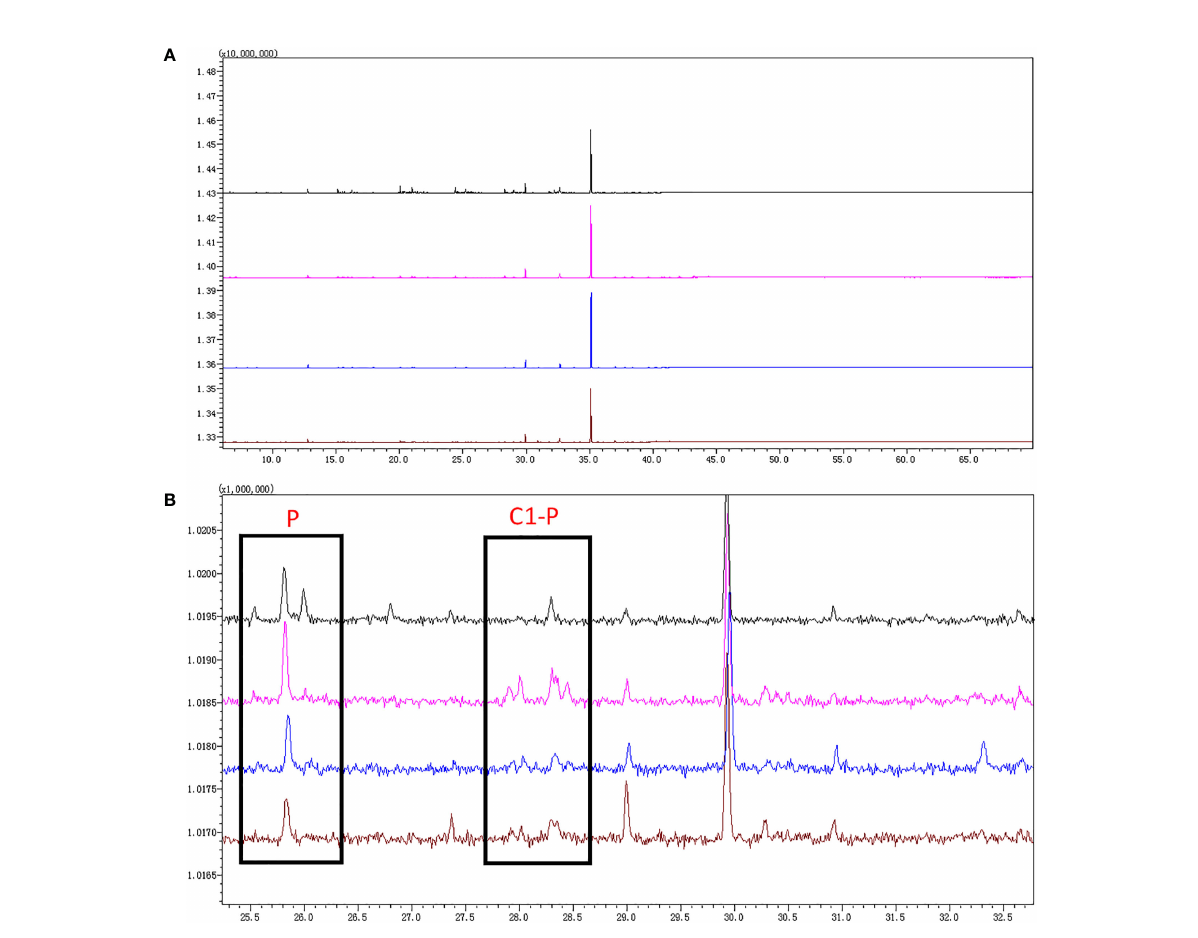
FIGURE 1 The total ion fl ow chromatogram (TIC) and mass chromatogram (Philippines series) of petroleum hydrocarbons in original surface water samples (A) and experiment samples (B) (from top to bottom represent blank group, U crude oil group, R crude oil group, T crude oil